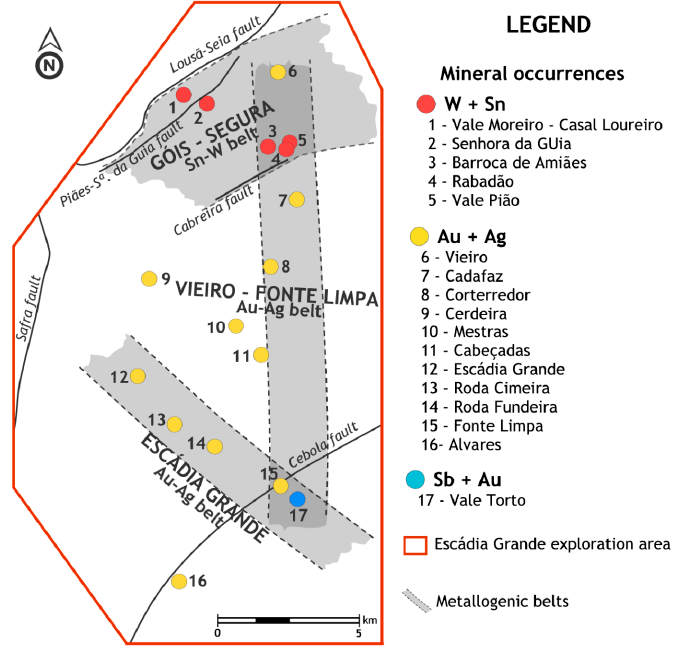
Figure 3. Mineral occurrences and metallogenic belts within the Escádia Grande exploration area (locations of the mineral occurrences and metallogenic belts E.D.M., S.A. and SIORMINP [34]).